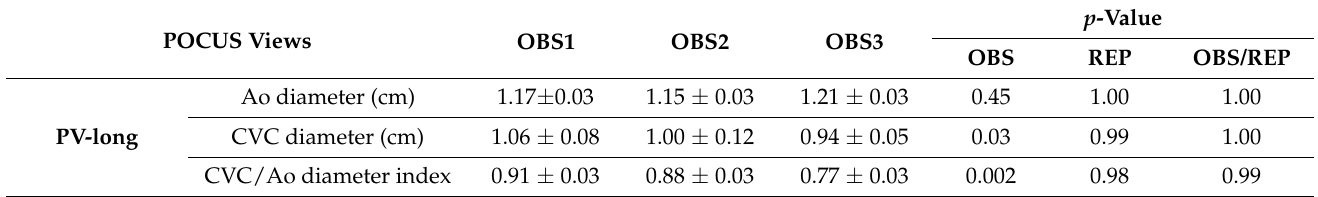
Table 1. Ultrasonographic measurements and calculated variables (mean and standard deviation ( ± SD)) obtained on images from the paralumbar view and subxiphoid view for each observer (OBS1, OBS2 and OBS3) in the intra- and interobserver agreement study, with p -values of effects of the observer (OBS), the repetition (REP), and interaction between observer and repetition (OBS/REP) on those